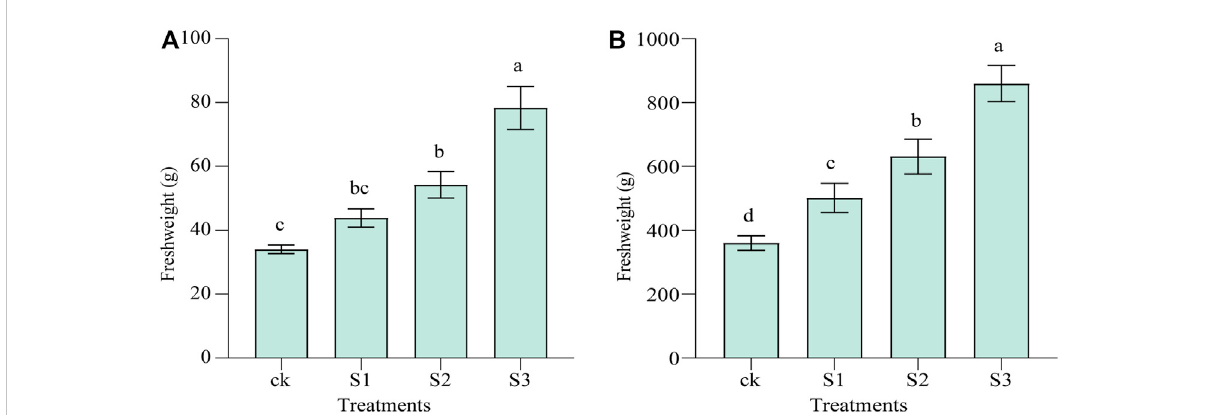
FIGURE 1 CK: soil without amendment; S1: soil amended with 10 mesh biochar and BOF at 10% (w/w), respectively; S2: soil amended with 30 mesh biocharandBOFat10%(w/w),respectively;S3:soilamendedwith60meshbiocharandBOFat10%(w/w),respectively;Errorbarsrepresentstandard errors of the means (n = 3). Different uppercase and lowercase letters indicate signi fi cant differences among treatments (p < 0.01) and (p < 0.05), respectively. (A) is in May, and (B) is in June.